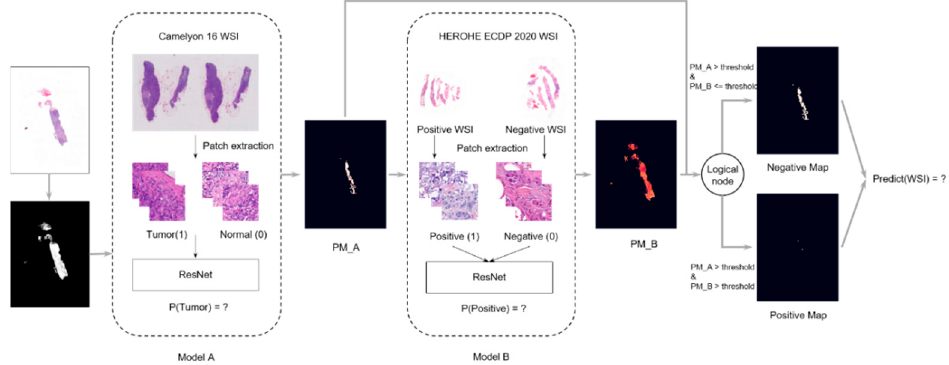
Figure 2. Overall architecture of the model developed by team Macaroon.